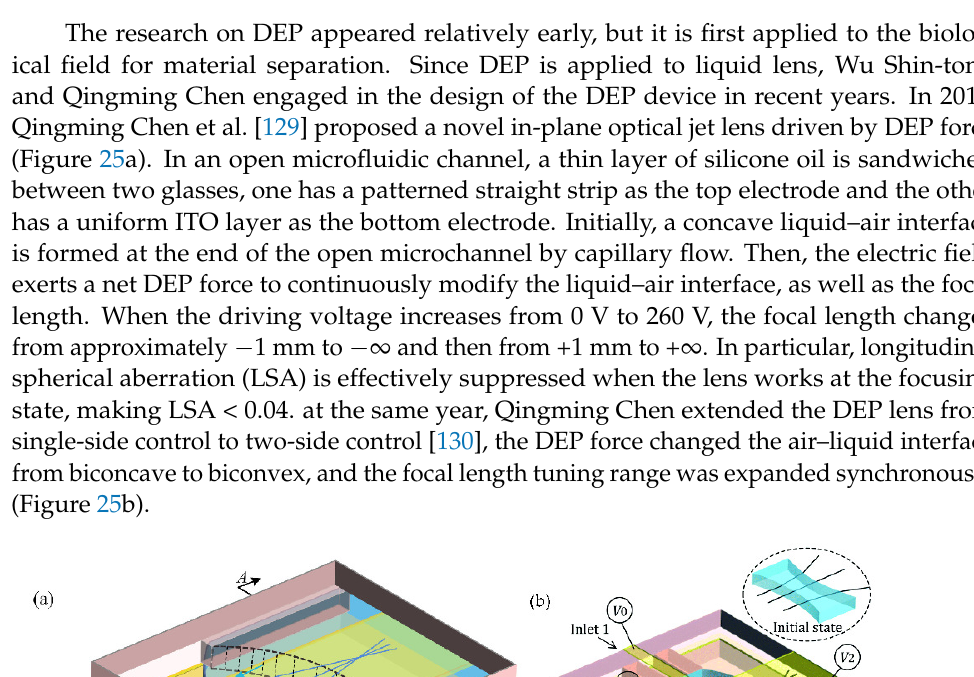
Figure 24. Schematics of the electrical setup to actuate the liquid–liquid interface by EWOD [128]. Reprinted with permission from Ref. [128]. 2019 Spring Nature.